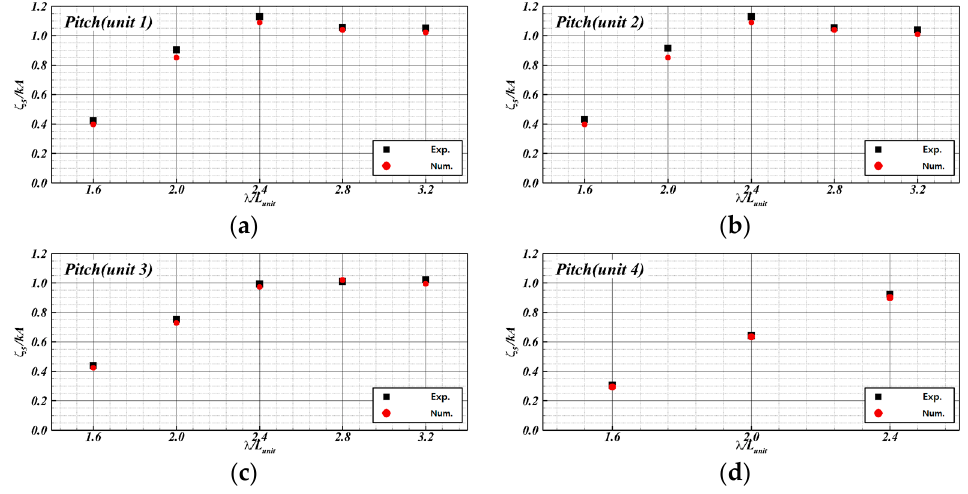
Figure 17. Pitch RAOs for 𝑯/𝝀 = 0.03 under head sea: ( a ) Unit 1; ( b ) Unit 2; ( c ) Unit 3; ( d ) Unit 4. At 𝐻/𝜆 = 0.03, 𝜆/𝐿 (cid:3048)(cid:3041)(cid:3036)(cid:3047) = 2.4, the time series data of the total tension was measured Table 6. Comparison of total tension determined by experiment and computation at H / λ = 0.03.